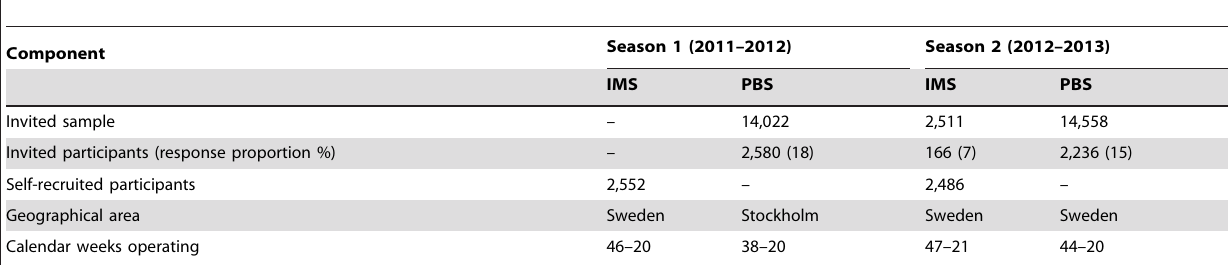
Table 1. Summary of system components of the IMS and PBS during the influenza seasons 2011–2012 and 2012–2013.